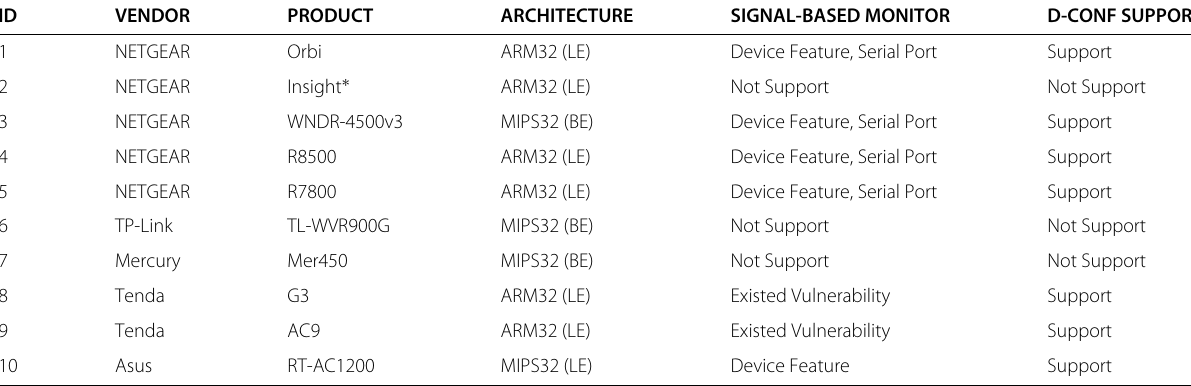
Table 2 Information of Routers under